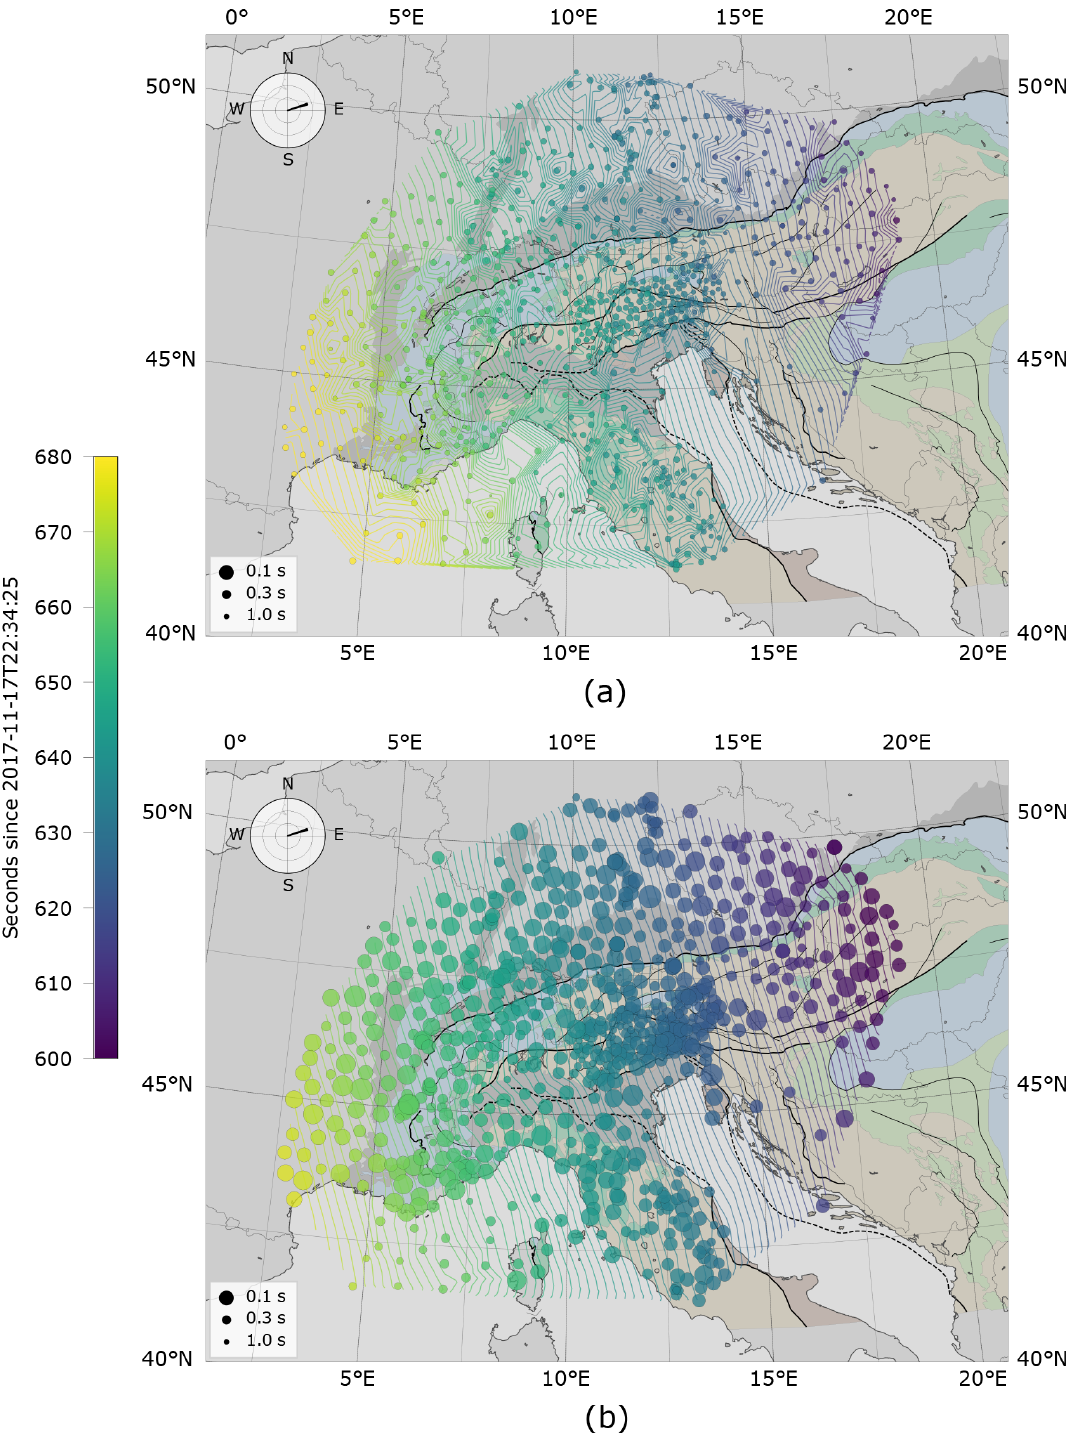
Figure 8. Travel-time fields of the Eastern Xizang–India Border Region event on 17 November 2017. Onsets from (a) the AIC algorithm that were only corrected for severe outliers (noise picks or wrong phases) and (b) the combined cross-correlation AIC algorithm. Onset certainty increases with circle sizes. Isolines are linearly interpolated with isochrone contour intervals of 1s.